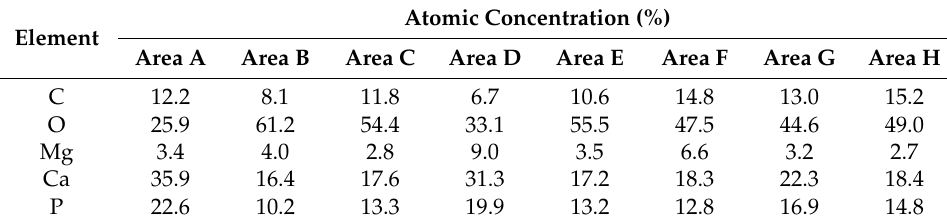
Table 1. Element composition of area A, B, C, D, E, F, G and H in Figure 2.